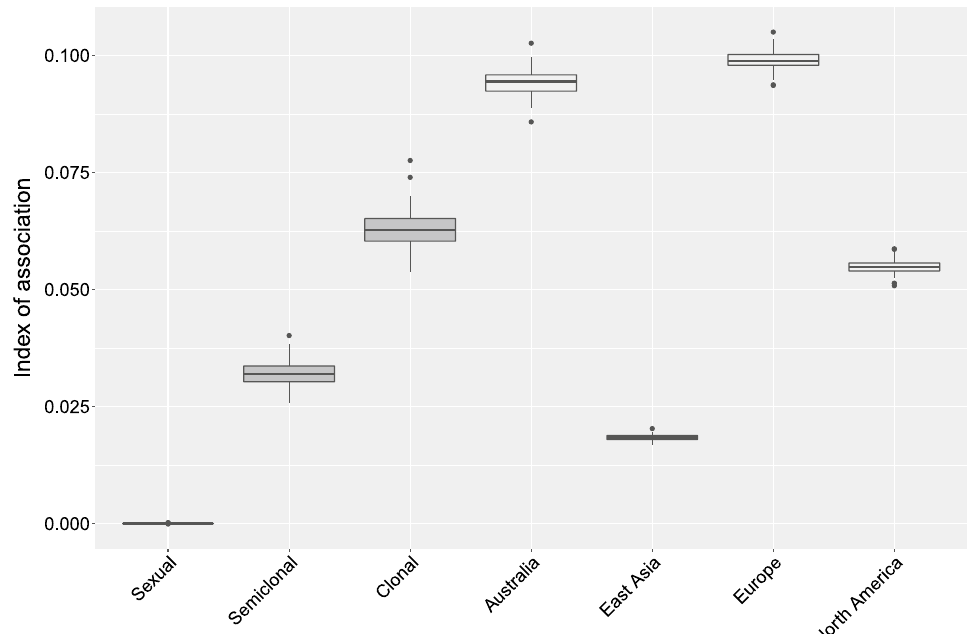
Fig. 3 Estimation of the degree of linkage disequilibrium by the index of association (I A ) in P. represent the I A for simulated populations under sexual, semiclonal, and clonal reproduction. All groupings were significantly different based on the Kruskal–Wallis rank sum